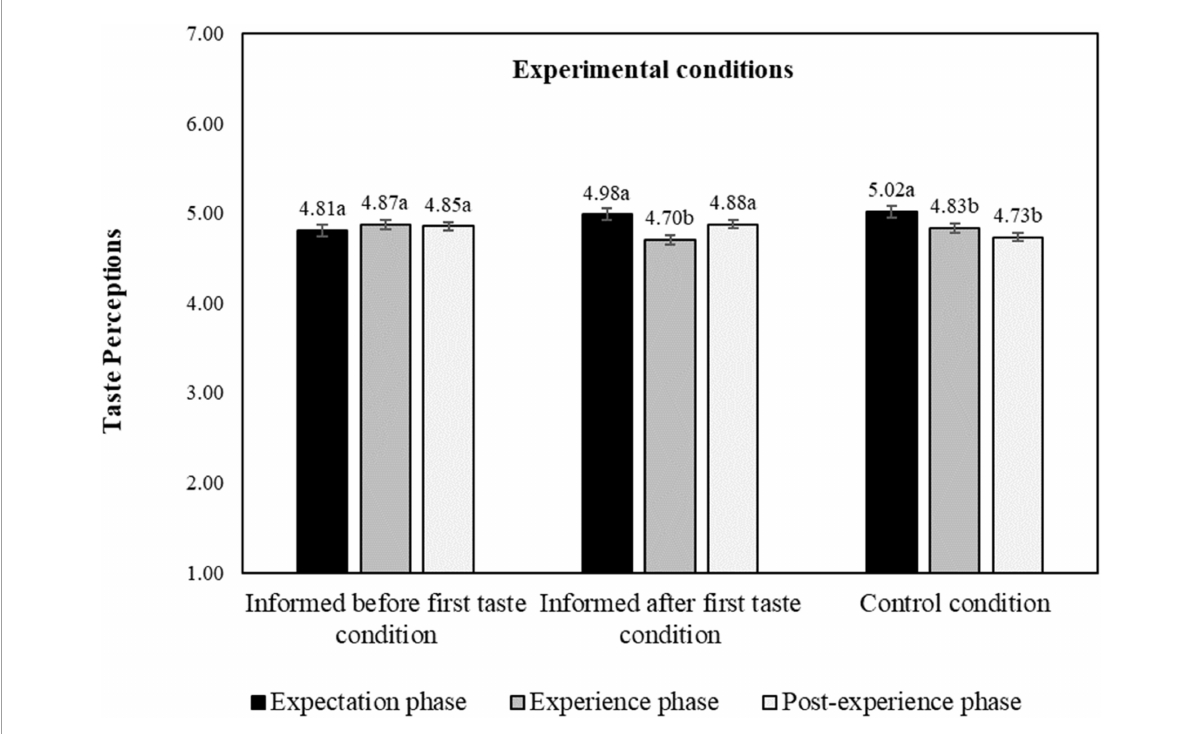
FIGURE9 Interaction effect of experimental conditions and product evaluation phase on taste perceptions, estimated marginal means. a–c: means with different letters are significantly different at p < 0.05 level; taste perceptions measured on a 9-point hedonic scale. The bars display standard